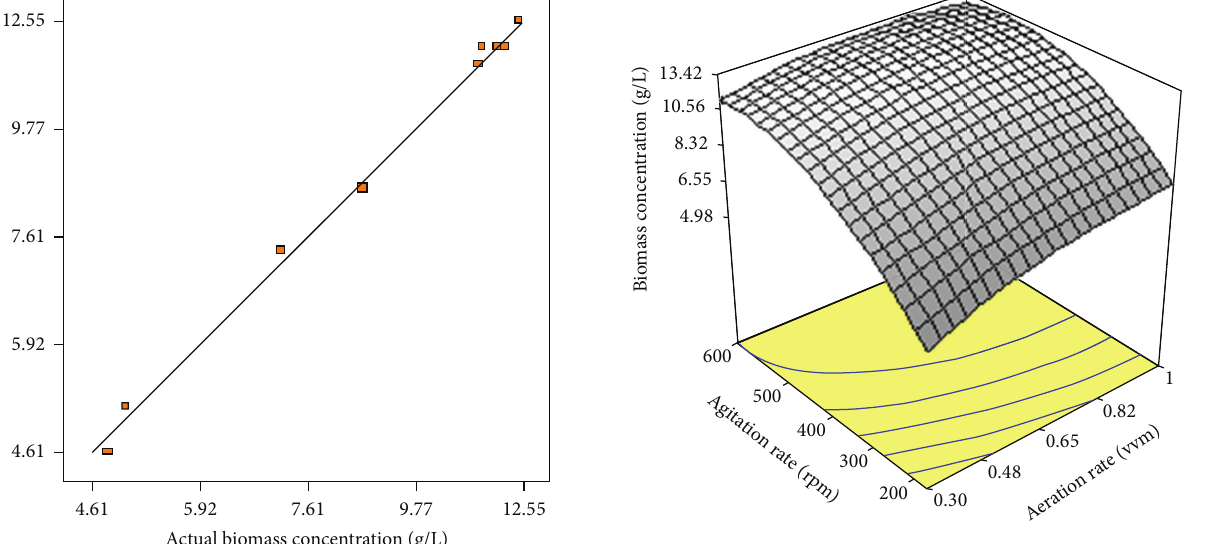
Figure 2: Response surface plot showing the simultaneous effects of aeration rate and agitation rate on biomass production by Cunninghamella bainieri 2A1.